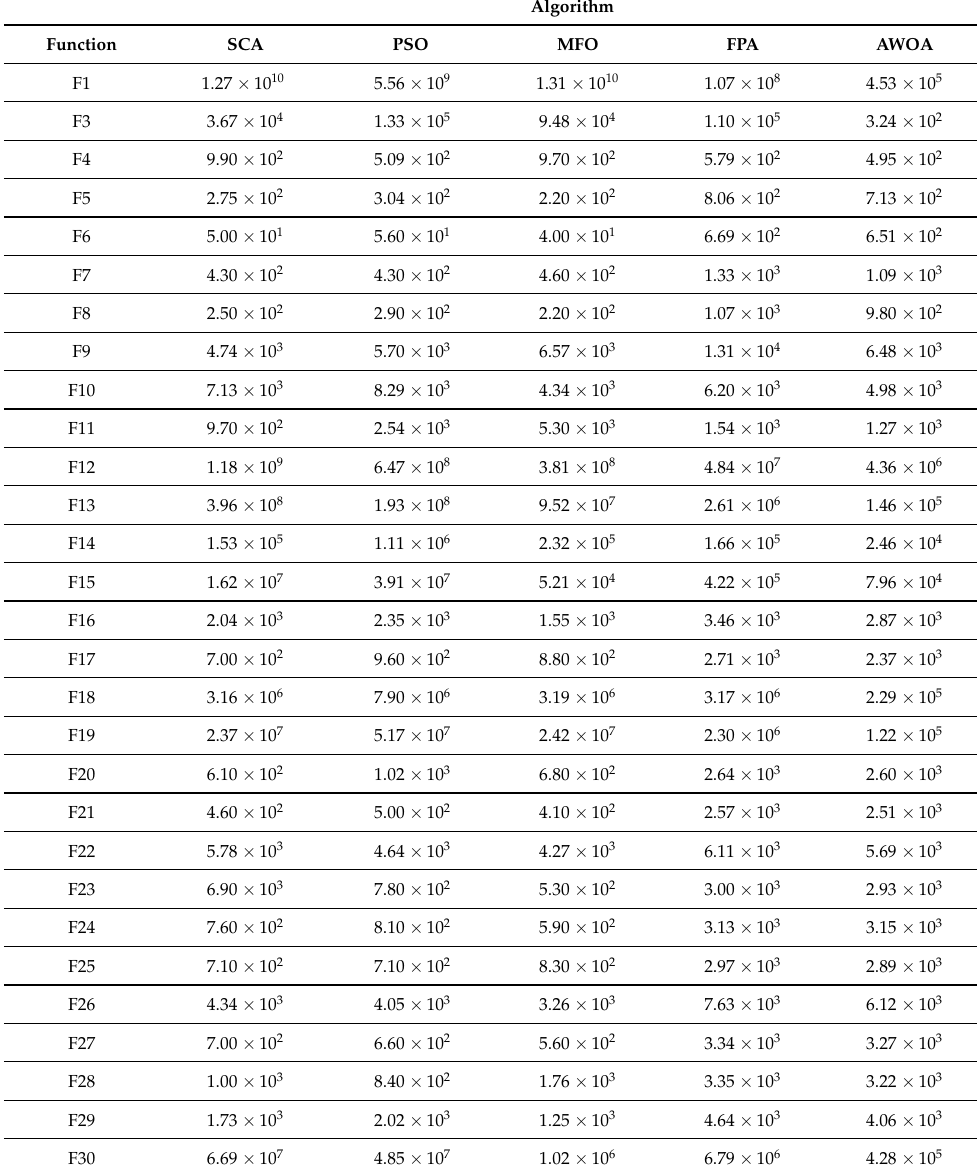
Table 9. Comparison of AWOA with other algorithms for